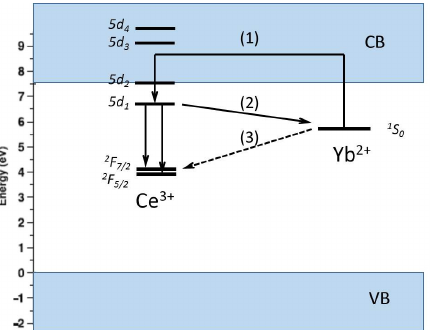
Figure 9. Energy level location of Ce 3+ and Yb 2+ in YAG. Pathways (1), (2), and (3) illustrate three different energetically possible electron transfer pathways to and from Ce and Yb in YAG (Adopted from You et al. [72]). CB = Conduction Band and VB = Valence